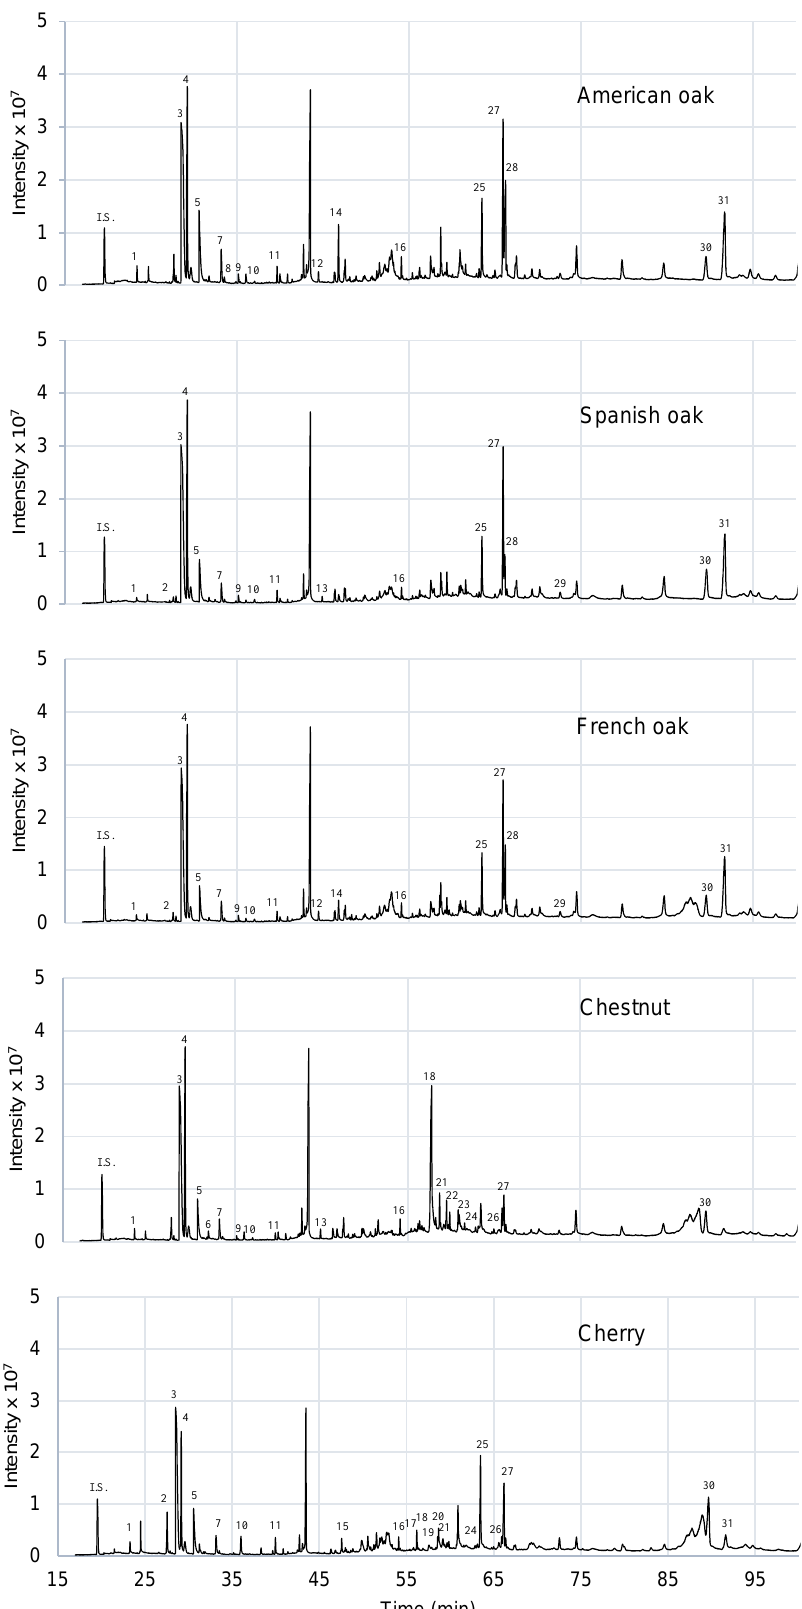
Figure 5. DTD-GC-MS chromatogram of the hydroalcoholic wood extracts. IS: Internal Standard (4-methyl-2-pentanol). The key for the compounds is in Table 7.